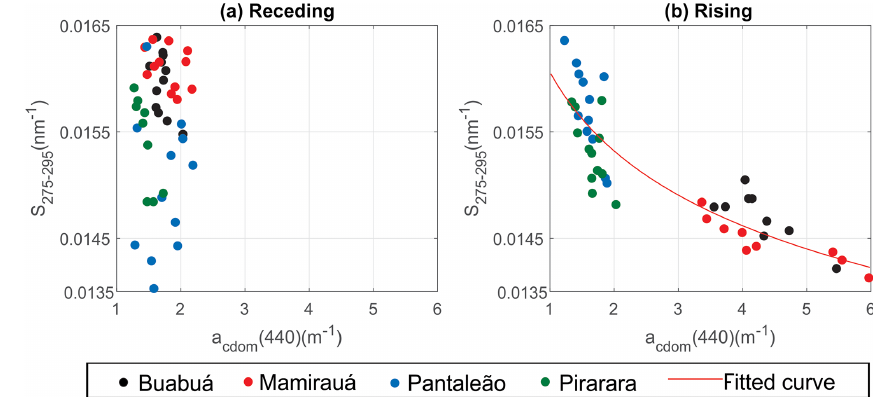
Figure 5. Scatterplot of a CDOM ( 440 ) (m − 1 ) versus S 275–295 (nm − 1 ) for the (a) receding and (b) rising limbs of the hydrograph.